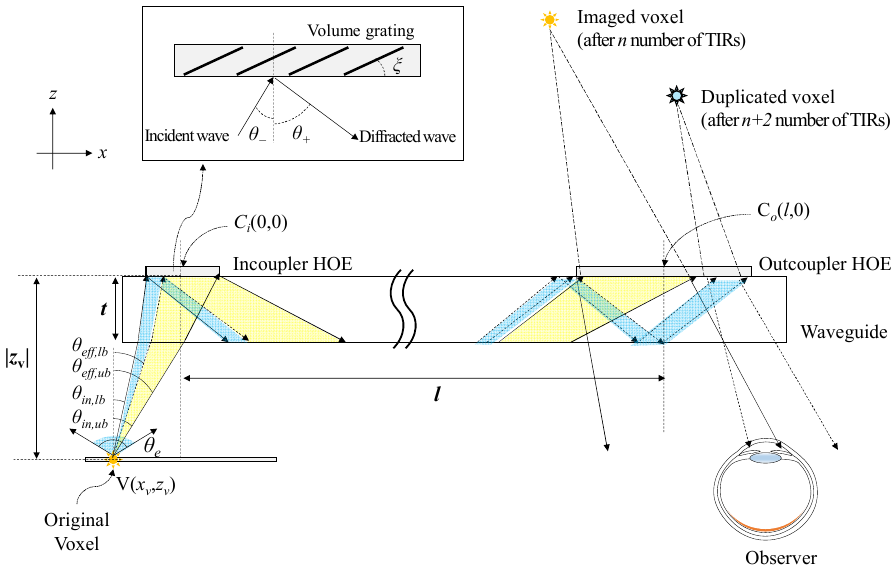
Figure 1. The schematic diagram for the voxel duplication problem in the holographic waveguide with the arbitrary voxels, which emit the non-collimated light with the large emission angle.